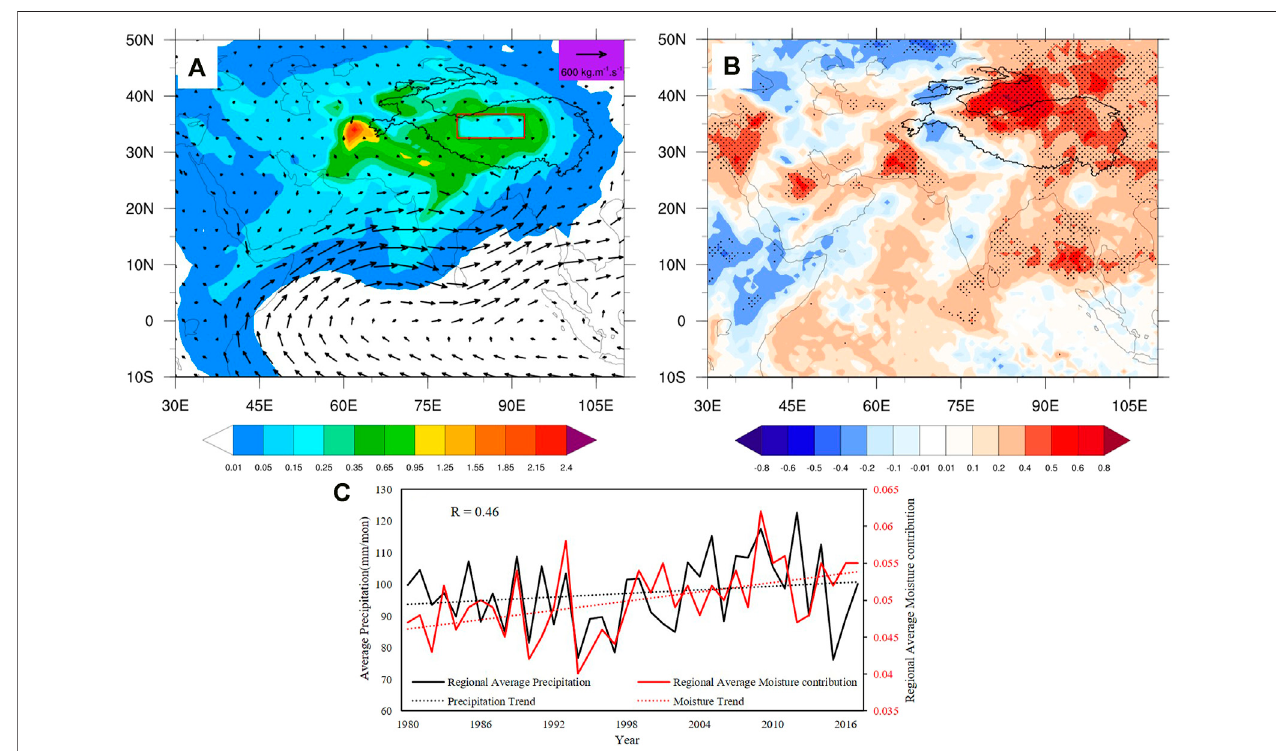
FIGURE 3 | (A) Horizontal spatial distribution of the climatological (1980 – 2017) integrated moisture source contribution, that is, the Lagrangian E-P diagnosed (E- P) > 0ofdays 1 – 10fortheTRHR(units:millimeter perday).Thevectorindicatestheverticallyintegratedwatervapor fl uxderivedfromtheERA-Interim (JJA,1980 – 2017, vector, in kgm − 1 s − 1 ). The target region for the water sources diagnosis is de fi ned as the continental areas within the red rectangular box (32.5 ° N – 36 ° N and 80.5 ° E – 92.5 ° E. (B) The interannual trend of the moisture contribution in the THRR for the period of 1980 – 2017. The dotted areas indicated the regions that exceeded the 0.05 signi fi cance level with the Student ’ s t test. (C) Time series of interannual regional average moisture sources (red) and the regional average summer mean precipitation (black) in the TRHR. The dot lines indicate the long-term trend,